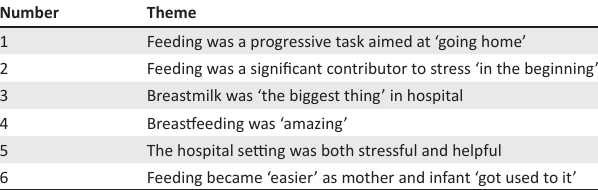
TABLE 2: Themes describing maternal experiences of feeding a preterm infant whilst